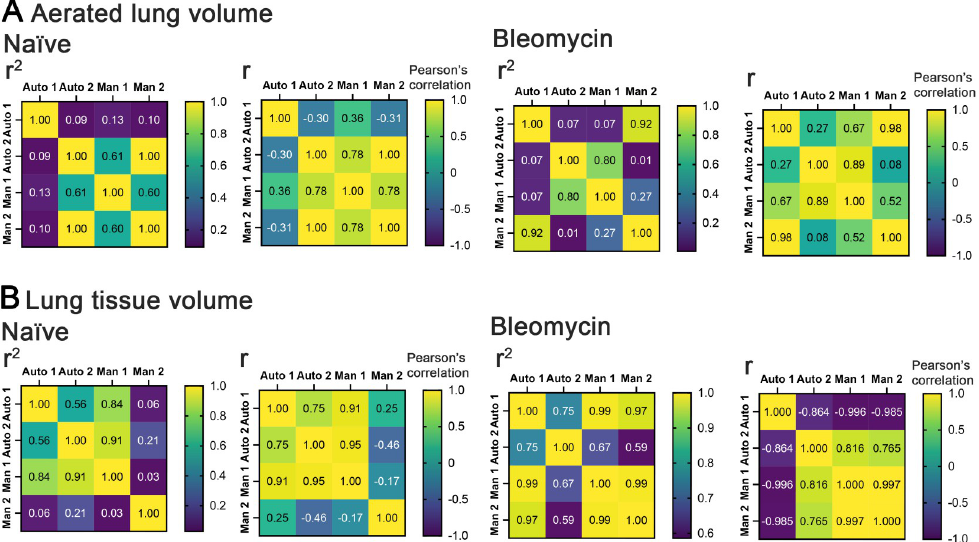
Fig 2. Correlation analysis between automated and manually generated ROIs. Respiration-gated Imaging in bleomycin induced fibrosis. Heat maps of: (A) aerated lung volume comparisons by R 2 and R (Pearson’s correlation) for na ï ve and bleomycin-treated mice. (B) Lung tissue volume comparisons by R 2 and R (Pearson’s correlation) for na ï ve and bleomycin- treated mice. Auto 1 = CTAn (Bruker) and Auto 2 = Amira-Avizo (ThermoFisher) automated generation of ROI. Man1 and Man2 = two independent generations of manual